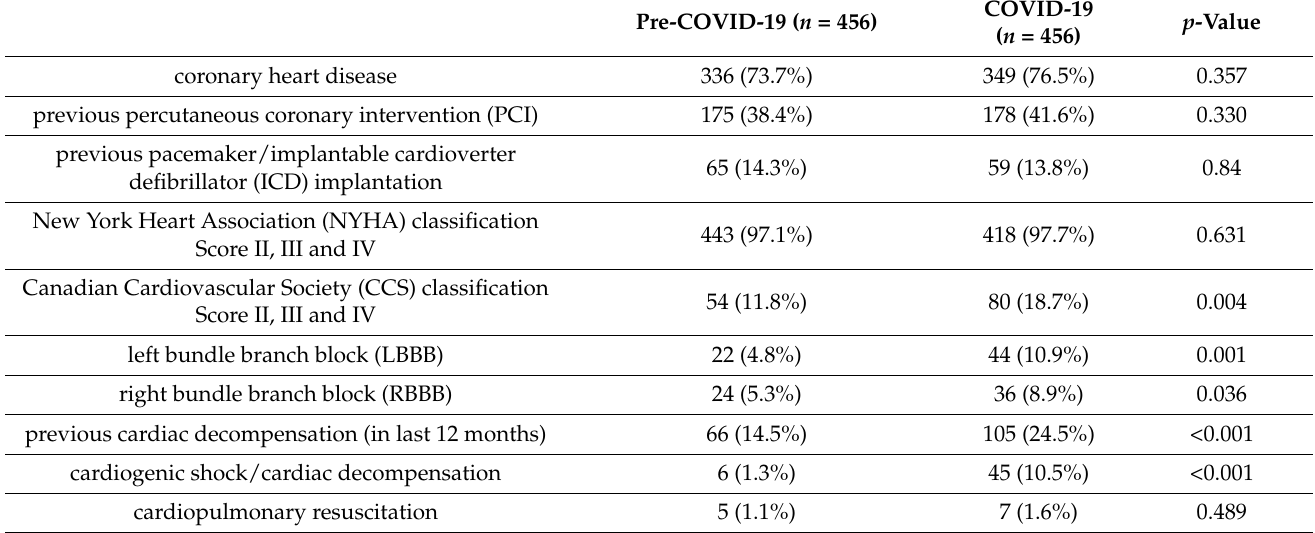
Table 4. Cardiac anamnesis/history.